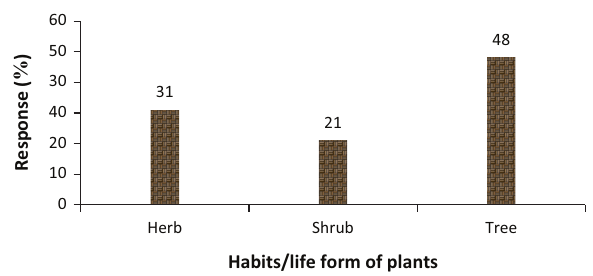
FIGURE 3: Habits or life forms of the plant species used by the traditional healers.